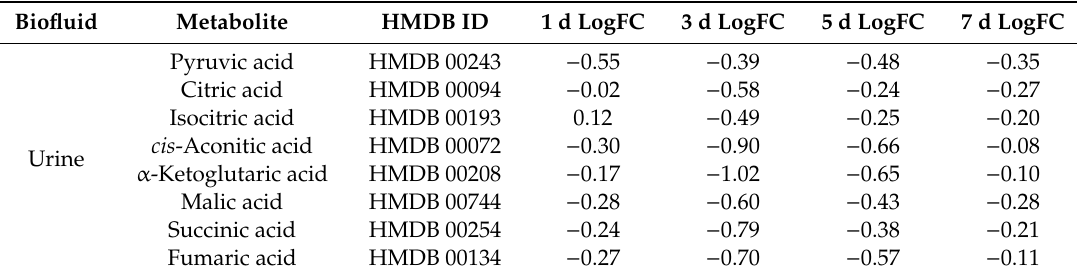
Table 3. Log fold changes (logFC) of urinary pyruvic acid and TCA cycle intermediates at 1, 3, 5, and 7 d after a 4 Gy γ radiation exposure in